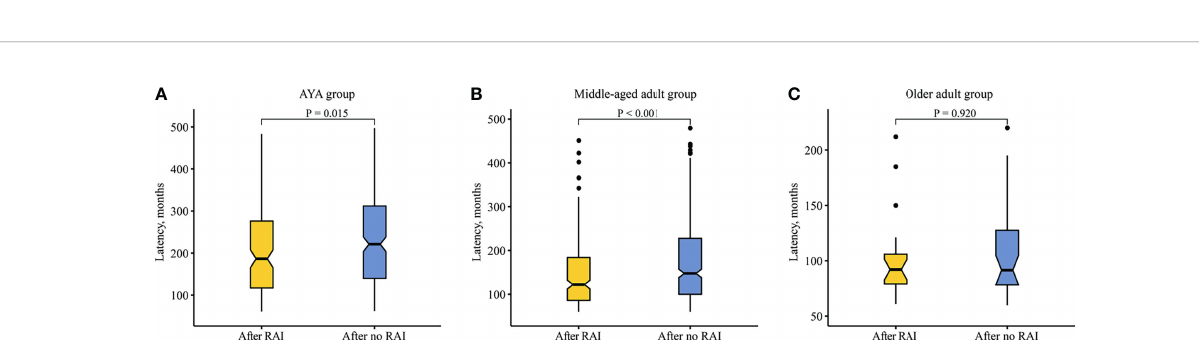
FIGURE 2 | Dynamic radioiodine-related hazard ratio strati fi ed by latency. (A) AYA group, (B) middle-aged adult group, and (C) older adult group. AYA, adolescent and young